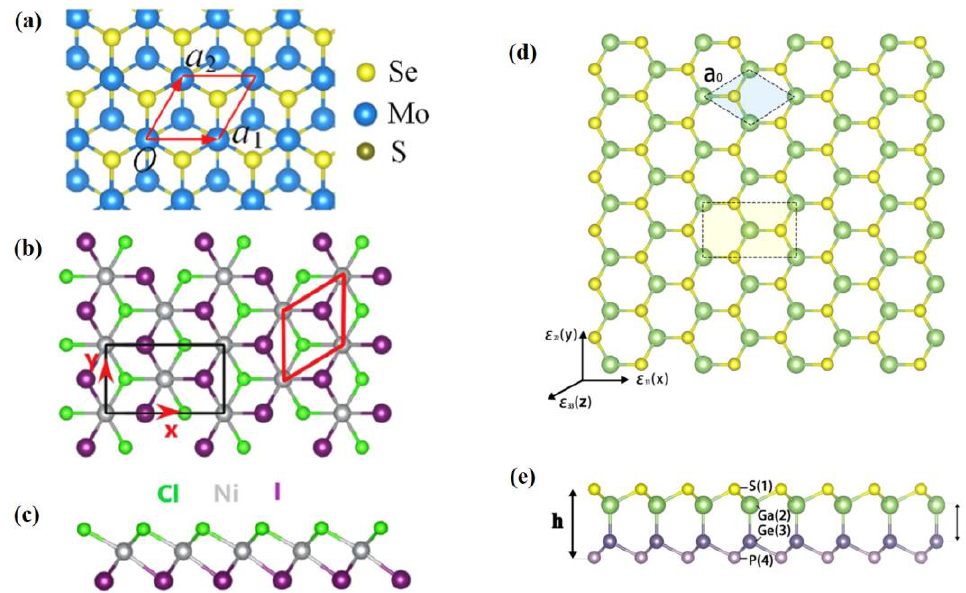
Figure 13. The schematic diagram of the ultrathin out-of-plane films [121–123]. ( a ) Top view of MoSSe. Reprinted from [122], copyright 2019, with permission from Elsevier. ( b ) Top view of NiClI. Reprinted from [121], with the permission of AIP Publishing. ( c ) Side view of NiClI. Reprinted from [121], with the permission of AIP Publishing. ( d ) Top view of the GeP–GaS monolayer. Reprinted from [123], copyright 2020, with permission from Elsevier. ( e ) Side view of the GeP–GaS monolayer. Reprinted from [123], copyright 2020, with permission from Elsevier.